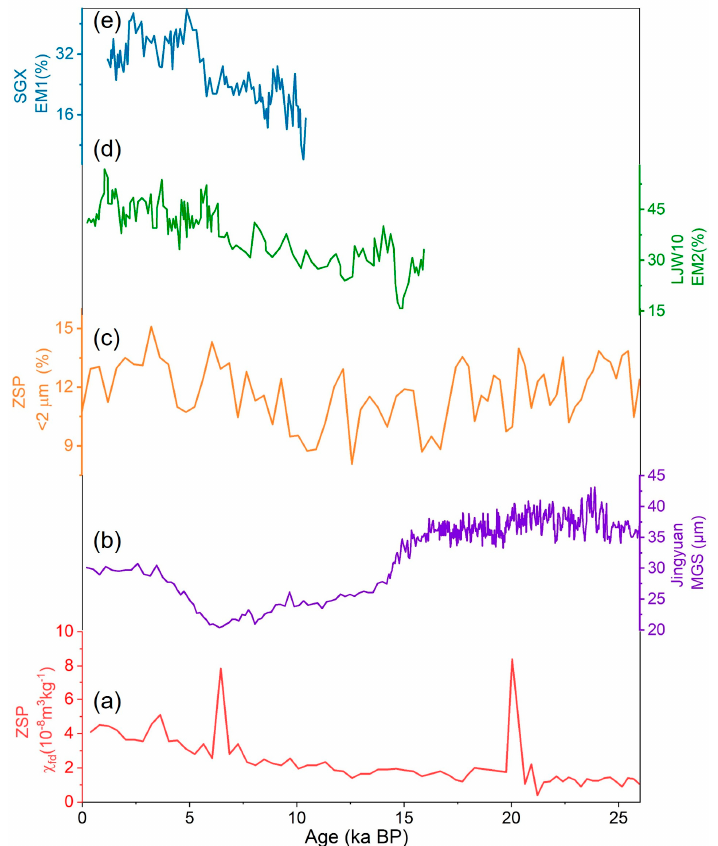
Figure 5. Comparison of the <2 μ m content of the ZSP section [35] ( c ), the EM2 (11 μ m) content of the LJW10 section in the northern Tianshan Mountains [90] ( d ), the EM1 (8.1 μ m) content of the SGX section in the southern Tibetan Plateau [91] ( e ), mean grain sizes (MGS) of Jingyuan loess in the western Chinese Loess Plateau [98] ( b ) and the χ fd of the ZSP loess [33] ( a ).